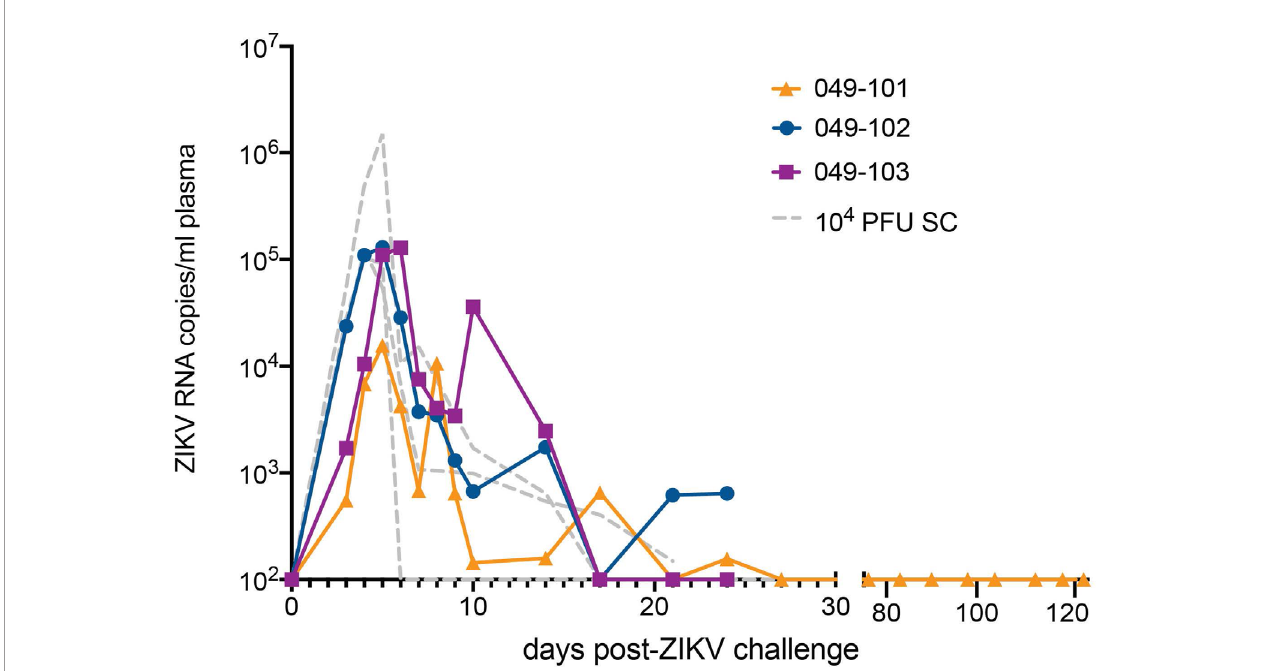
FIGURE 2 | Intravaginal ZIKV challenge resulted in detection of vRNA in plasma for all three dams. The x-axis shows days post-ZIKV challenge. The y-axis starts at the estimated limit of quanti fi cation of the qRT-PCR assay (1x10 2 copies/ml) and is shown as copies/ml plasma on the log scale. Plasma vRNA loads are displayed for dam 049-101 as orange triangles, for dam 049-102 as blue circles, and for dam 049-103 as magenta squares. For comparison, ZIKV plasma vRNA loads are also shown for three pregnant macaques subcutaneously (SC) inoculated with 1x10 4 PFU ZIKV-DAK and are displayed as gray dashed lines and noted as 10 4 PFU SC in the legend